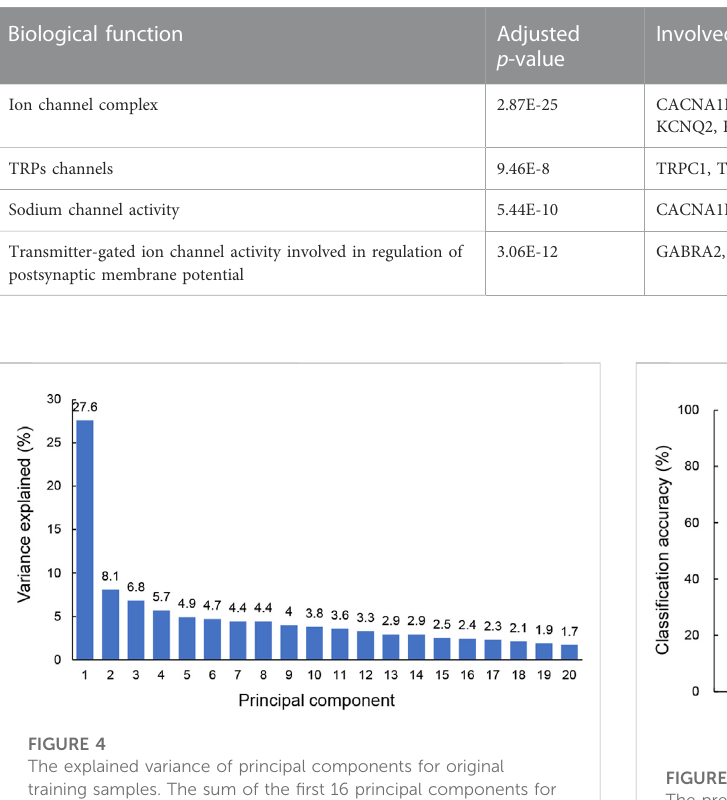
TABLE 1 Functional annotation for the selected 20 hub genes.